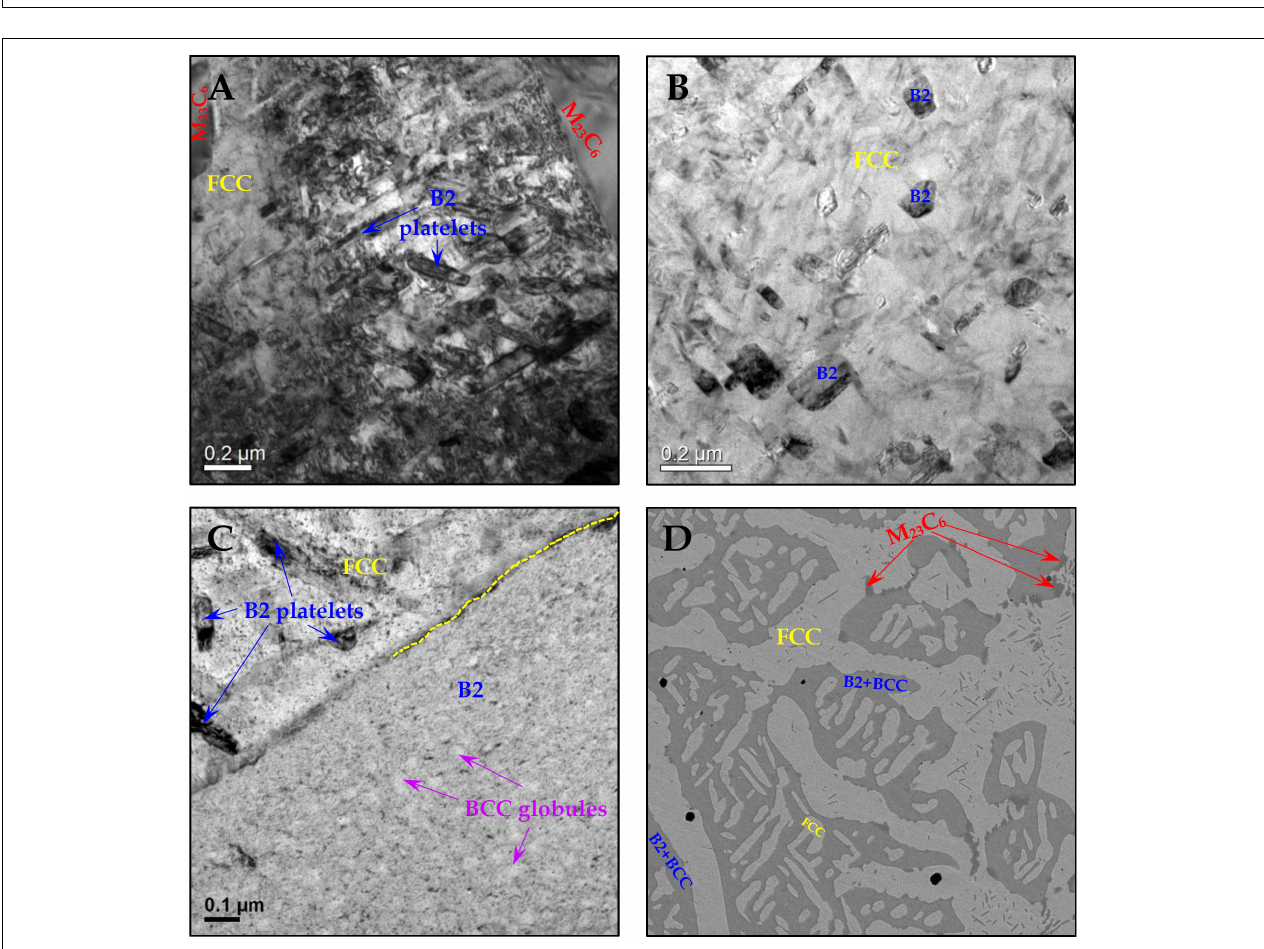
FIGURE 10 | (A–C) BF-TEM micrographs showing the general morphology of the phases and precipitates comprising the microstructure in homogenized and aged (750 ◦ C) AlCrFe 2 Ni 2 alloy; (D) HRSEM micrograph showing the general microstructure in aged (750 ◦ C) AlCrFe 2 Ni 2 alloy.